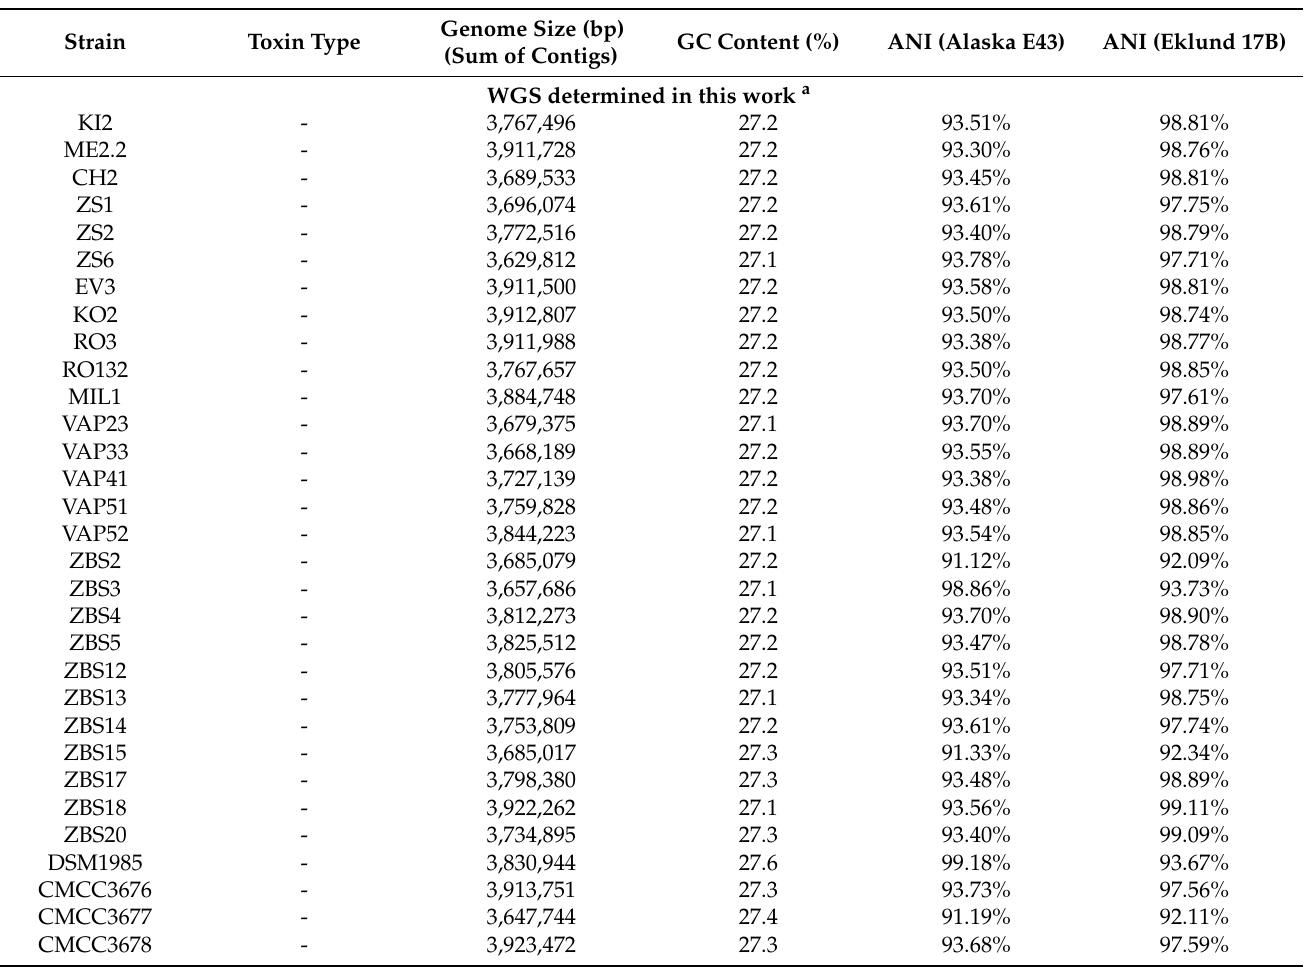
Table 4. Genomic characterization of nontoxic and toxic nonproteolytic C. botulinum . ANI was calculated with toxic strains Alaska E43 and Eklund 17B, representative of the previously identified type E and type BEF clusters of group II C. botulinum . Toxic strains: